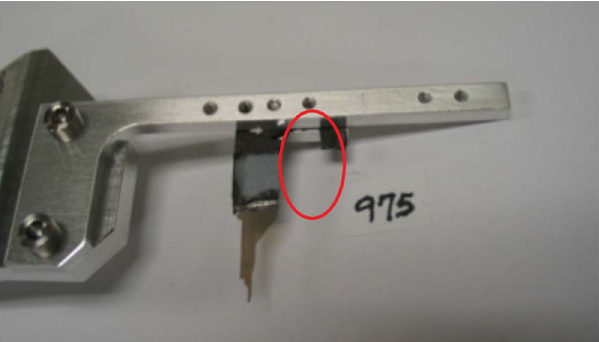
FIG. 8. An example of a fractured foil substrate on a third- generation foil bracket. The ellipse indicates the area where the substrate fractured and pieces fell